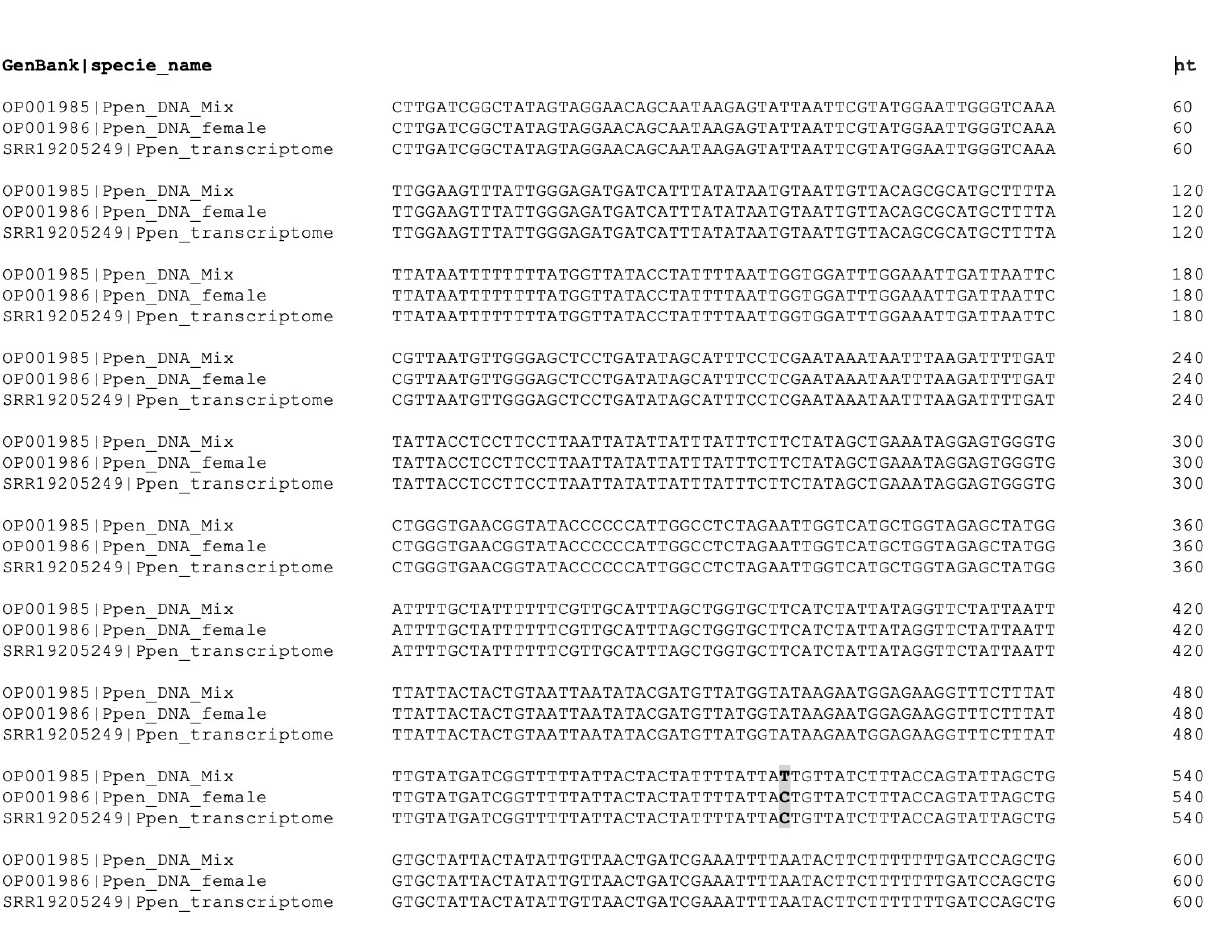
Figure 2. Multiple sequence alignment of Phonotimpus pennimani coxI fragment. Ppen : Phonotimpus pennimani ; DNA_Mix corresponds to amplified sequence from total DNA of a mixed population (females and males; GenBank OP001985); female_DNA corresponds to sequences amplified from total DNA of a population of females (GenBank OP001986); transcriptome corresponds to a sequence obtained from the P. pennimani transcriptome (SRA: SRR19205249, ID sequence